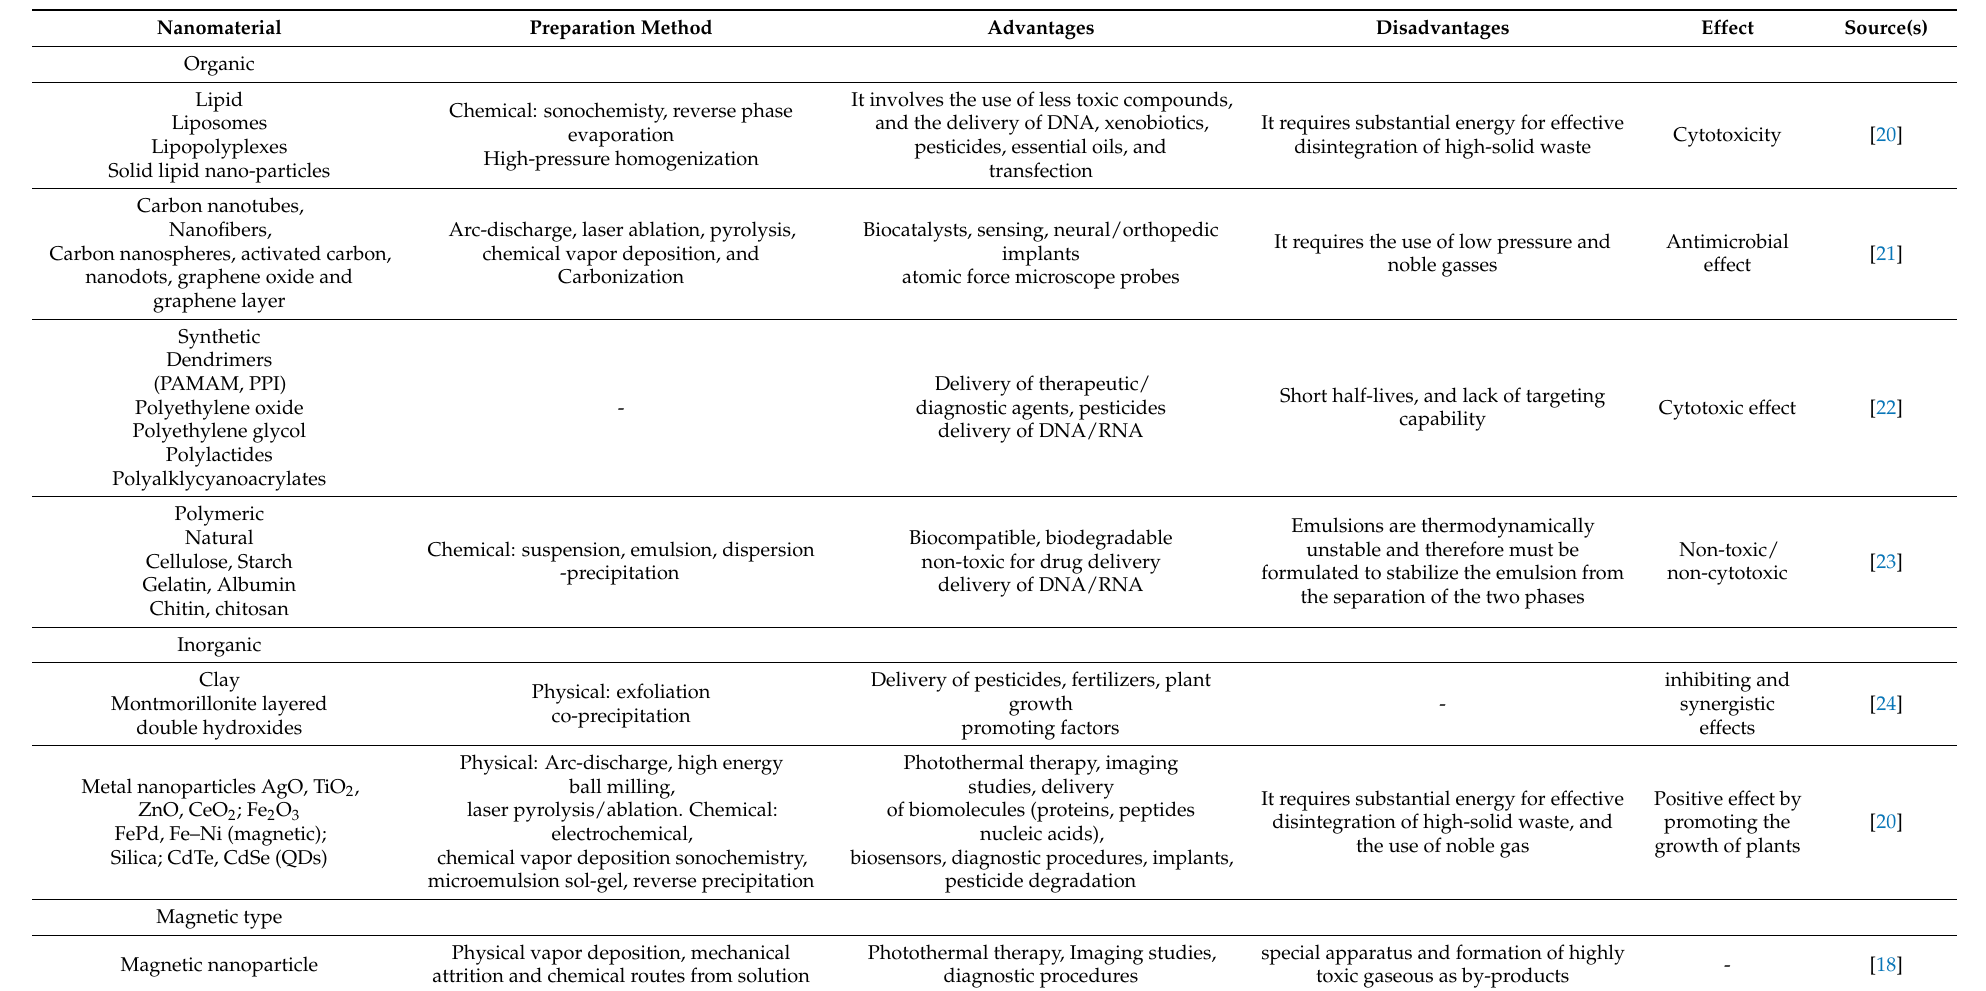
Table 1. Nanomaterials, methods of nanoparticles synthesis, effects and their